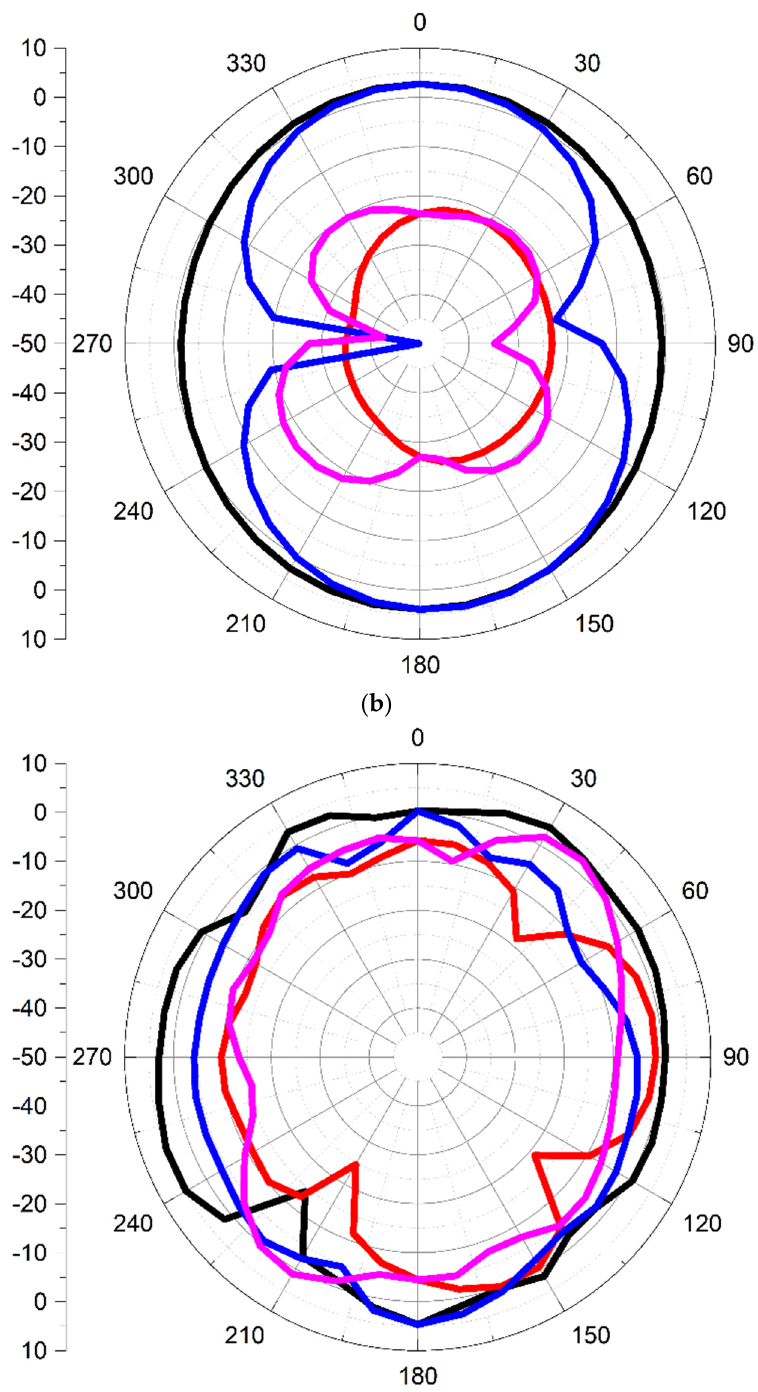
Figure 23. The simulated radiation pattern at ( a ) 4 GHz, ( b ) 6.2 GHz, and ( c ) 11.7 GHz. At 4 GHz and 6.2 GHz, an omnidirectional pattern is detected in the E ‐ plane, while a bidirectional pattern is observed in the H ‐ plane. At 11.7 GHz, an omnidirectional pattern is seen in the E ‐ plane and the H ‐ plane.